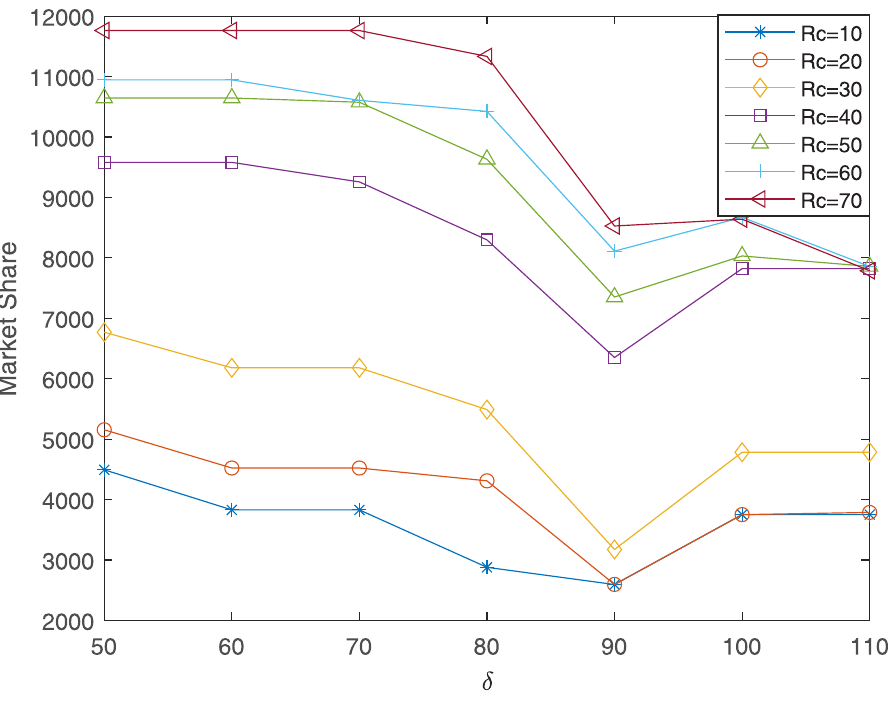
Fig 6. The relationship between market share and δ ( R